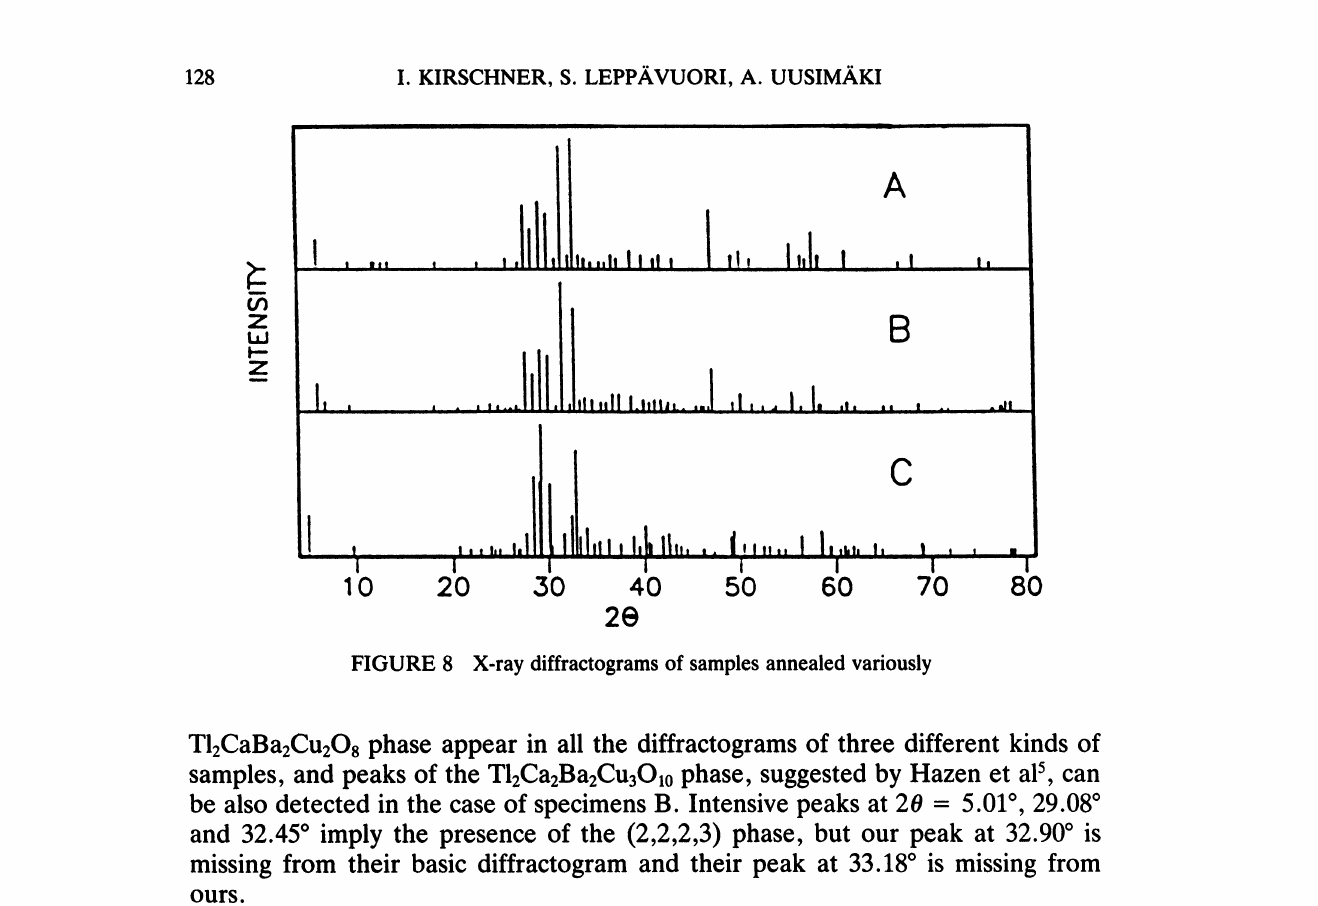
FIGURE 8 X-ray diffractograms of samples annealed